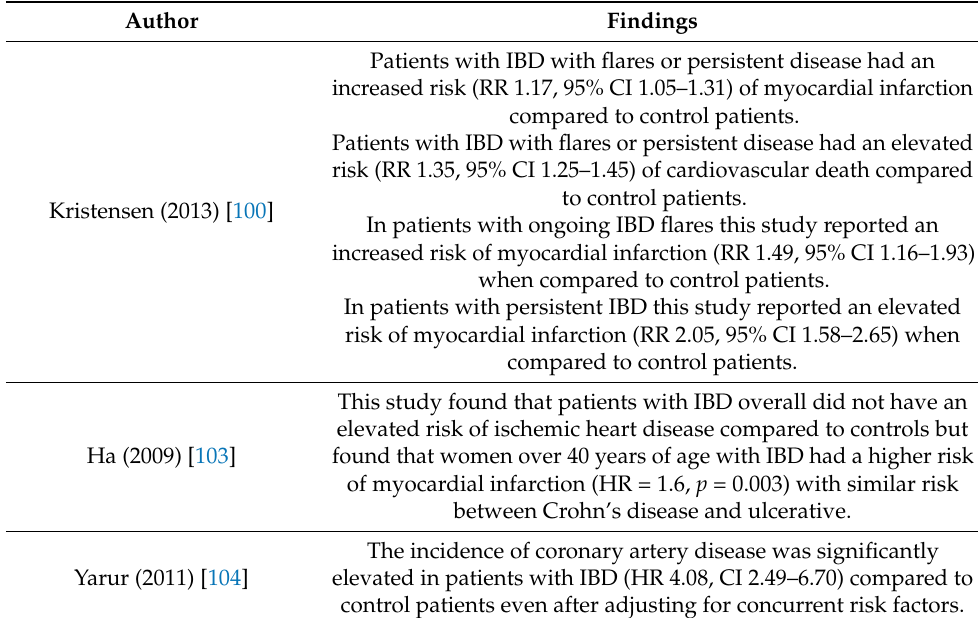
Table 2. Summary of studies reporting the risk of ischemic heart disease in patients with